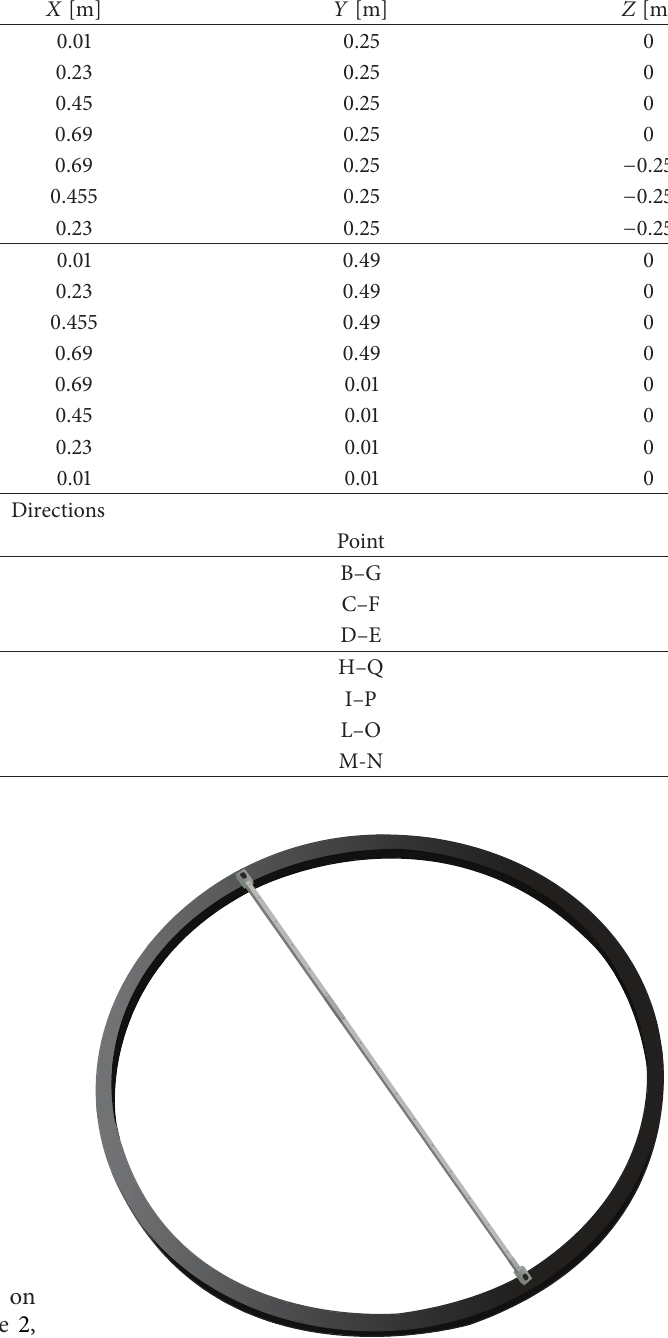
Figure 15: Ring pressure transducers support